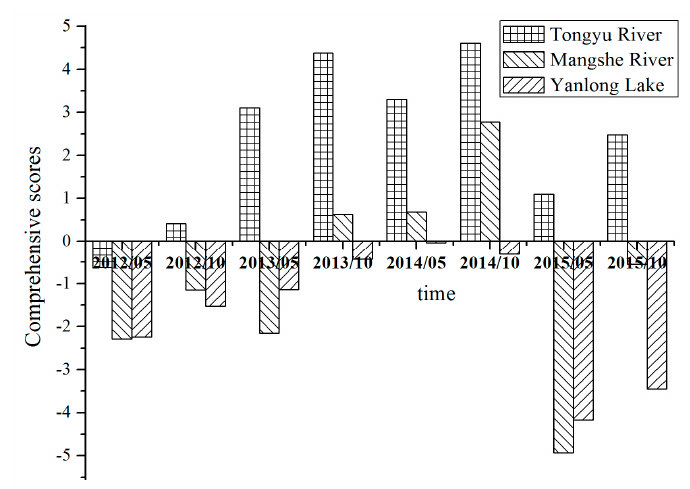
Figure 10. Comprehensive score of drinking water sources.